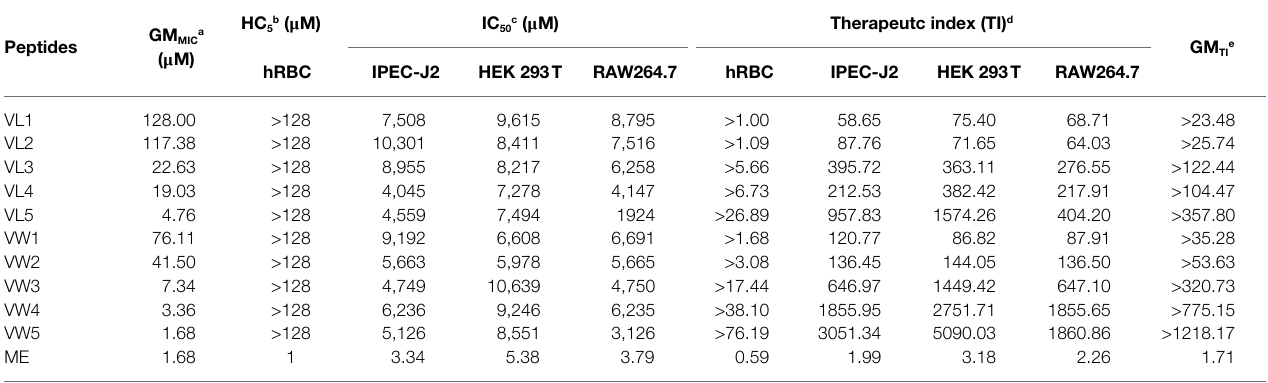
TABLE 3 | The biocompatibility of antimicrobial peptides.